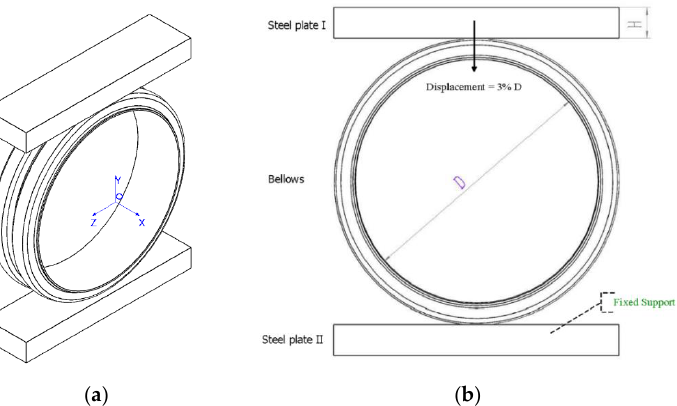
Figure 2. Finite element model of bellows ring stiffness calculation. ( a ) and ( b ) ab are different perspective of the finite element